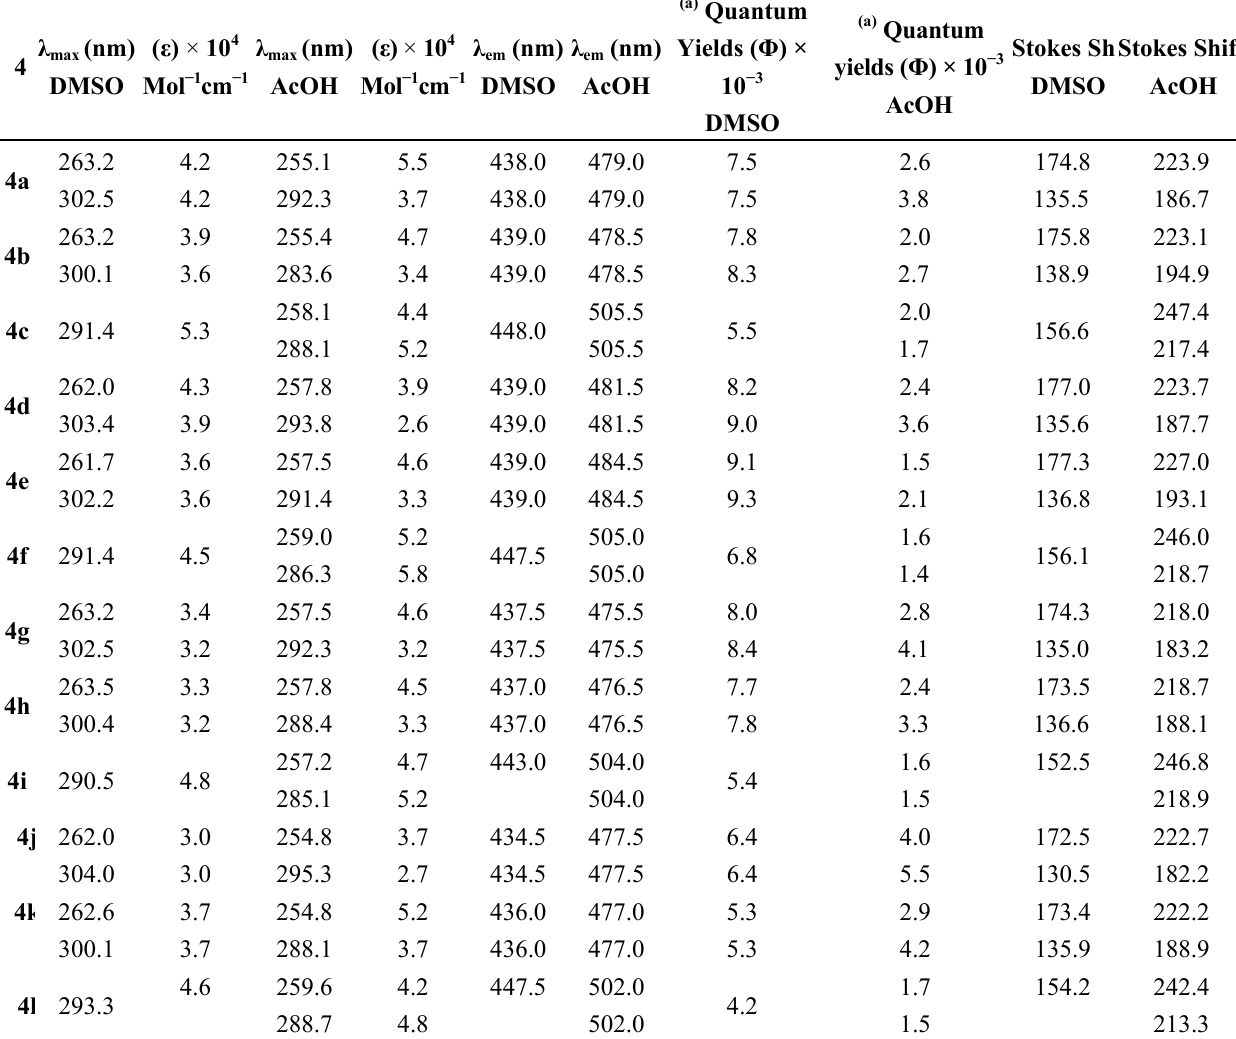
Table 2. The absorption and emission data for compounds 4a – l